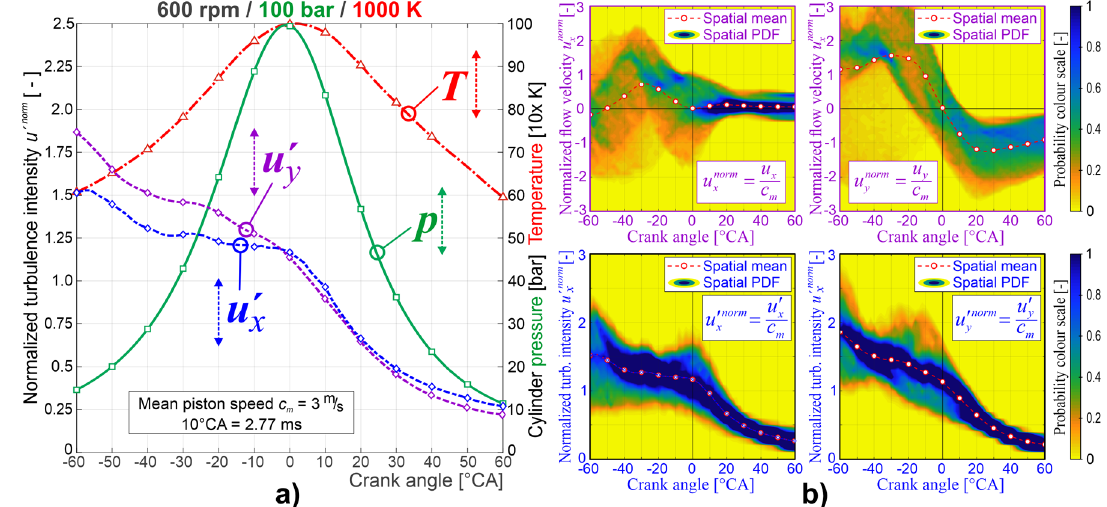
Figure 16. Normalized, spatially averaged flow velocity magnitude and ensemble averaged